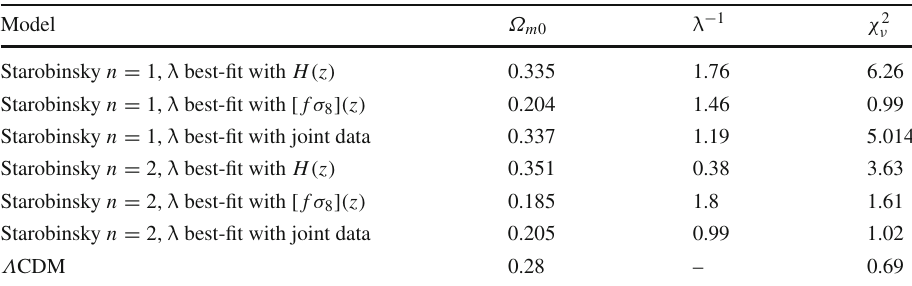
Table 5 Goodness of fit test, measured by χ 2 ν through the analysis of the binned data in Table 3, to compare the behavior of the Λ CDM and 3 Starobinsky models (each with a best-fitted λ parameter provided by the MCMC runs considering 3 data sets)